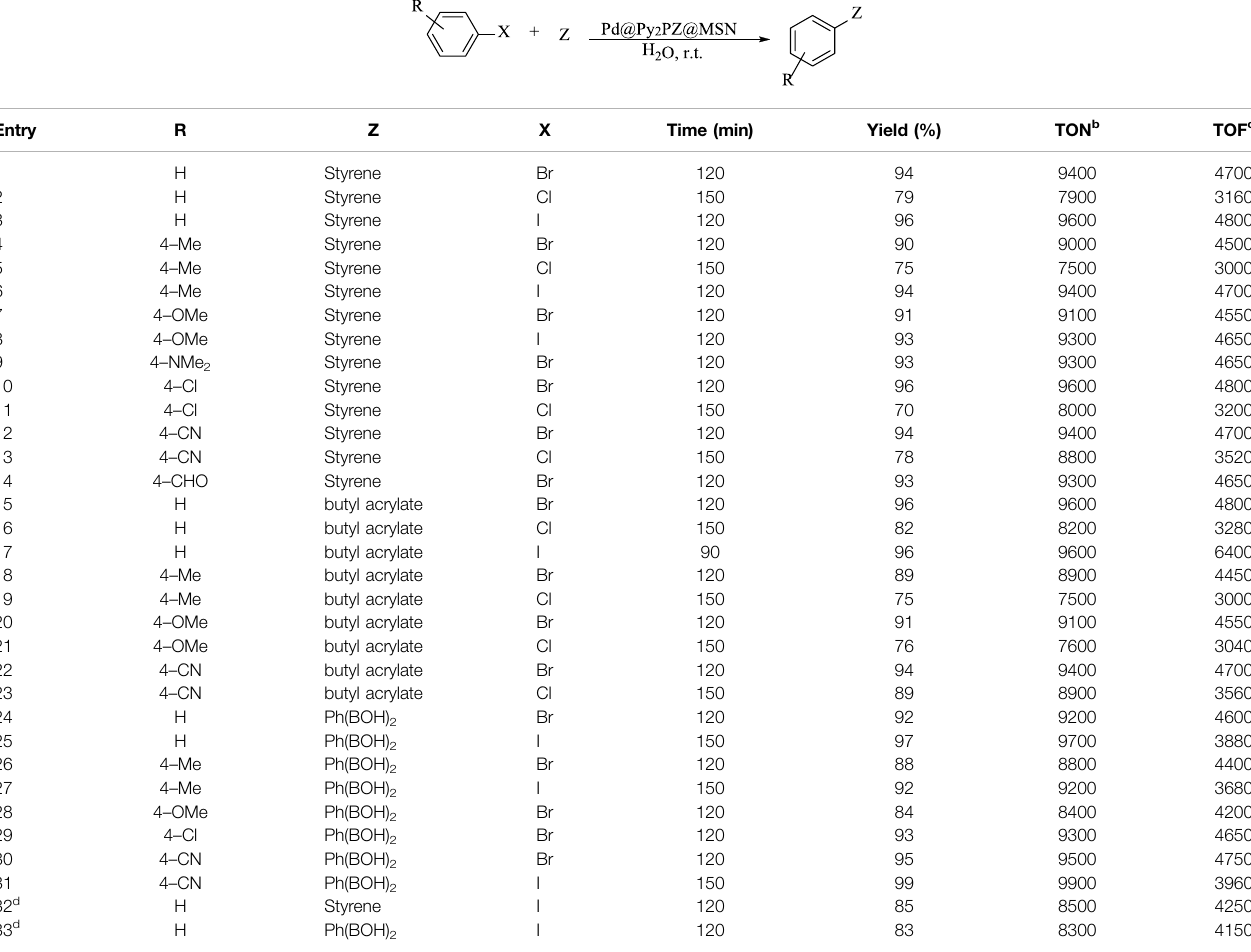
TABLE 3 | Scope and generality of the Pd@Py 2 PZ@MSN catalyst in Heck and Suzuki reactions a .